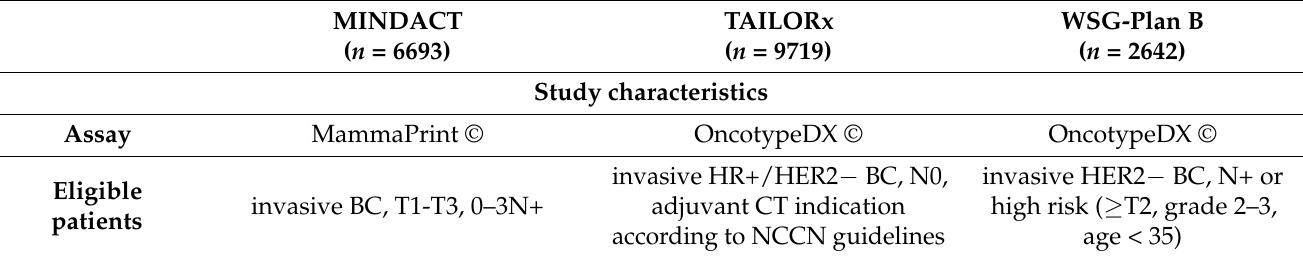
Table 2. Main characteristics of recent phase III randomized clinical